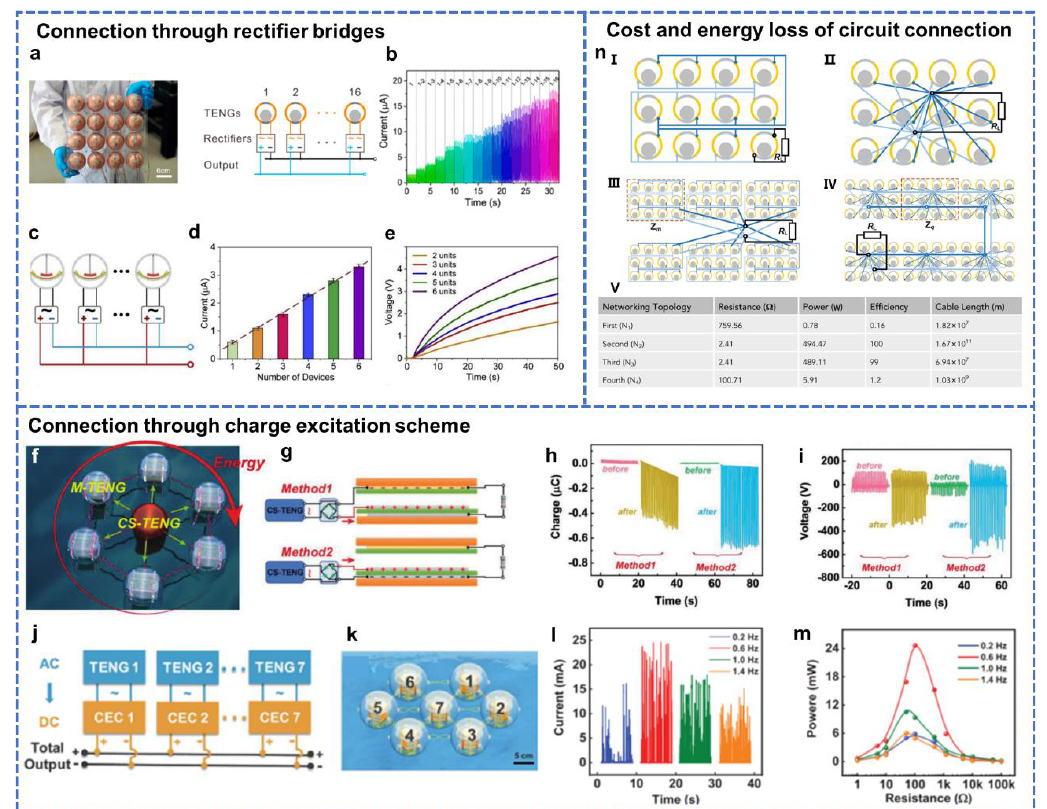
Figure 4. ( a ) Photograph and circuit connection of the square 4 × 4 network based on the ball – shell TENG unit. ( b ) Rectified short current of the network as the unit number increases from 1 to 16. ( a ) ( b ) Reprinted with permission from ref. [57], Copyright 2018, American Chemical Society. ( c ) Schematic diagram of the rectification circuit for the network composed of the pendulum-inspired TENGs. ( d ) Output current and ( e ) charging performance for different unit numbers. ( c – e ) Reprinted with permission from ref. [61], Copyright 2019, Elsevier. ( f ) Self-charge-supplement TENG network. ( g ) Each unit of the M-TENGs containing three electrode layers and two dielectric layers. ( h ) Transferred charge and ( i ) output voltage for the TENG before and after the charge supplement by two methods. ( f – i ) Reprinted with permission from ref. [65], Copyright 2019, Willey. ( j ) Parallel connection of the units in the TENG network through the CECs without rectified bridges. ( k ) Diagram of the hexagonal TENG network integrated with the CECs. ( l ) Output current and ( m ) output power-resistance profiles of the charge-excitation TENG network for various water waves. ( j – m ) Reprinted with permission from ref. [66], Copyright 2020, Willey. ( n ) Four fundamental forms of electrical networking for large-scale TENG networks and list of merits and demerits. Reprinted with permission from ref. [67], Copyright 2020, Elsevier.